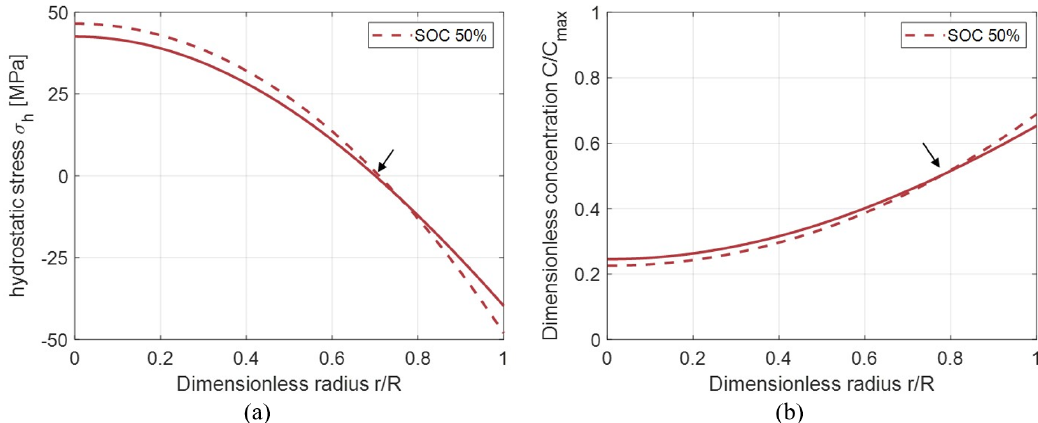
Figure 10. Hydrostatic stress ( a ) and concentration ( b ) in cathode material. Black arrows show the points where the hydrostatic stress changes sign which partially reflect the turnaround of the concentration function. Dashed lines refer to the uncoupled model and solid lines refer to the coupled